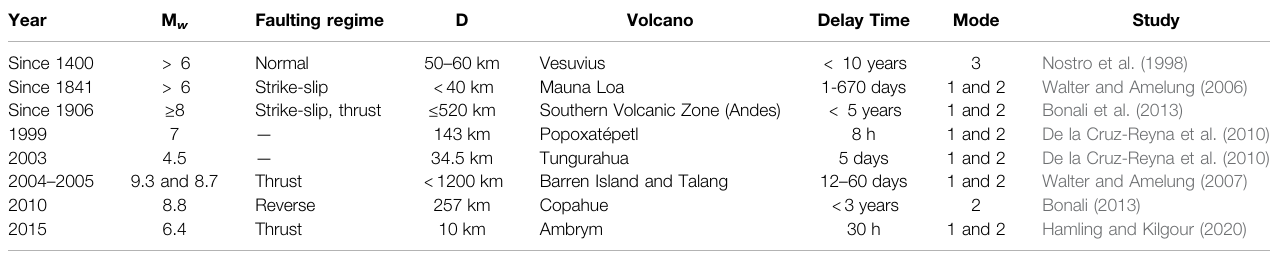
TABLE1| SelectedexamplesofCoulombfailurestresstransfertomagmaticsystemscausingthetriggering(orpartialtriggering)oferuptions.Threemodesareproposed:1) unclamping of magma conduits above reservoir, 2) unclamping of magma conduits below reservoir, 3) direct clamping of the magma reservoir due to displacement on fault planes. Moment magnitude of earthquake (M w ), horizontal distance (D) distance between earthquake epicenter and volcanic